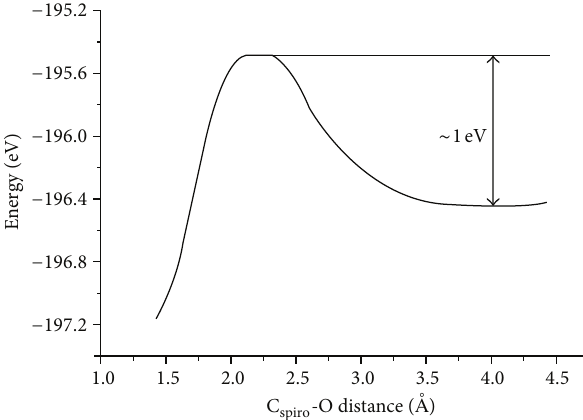
Figure 6: The dependence of energy from distance between C spiro and O atoms for the